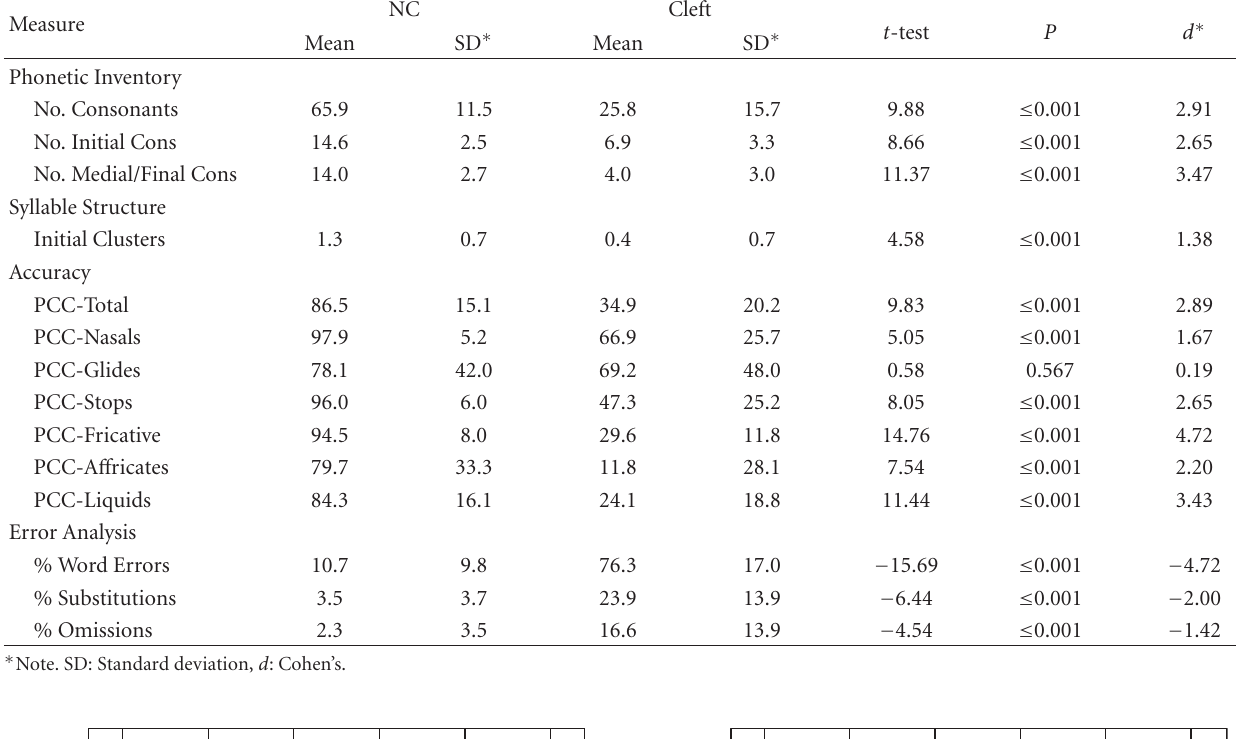
Table 2: Mean and standard deviation for PEEPS measures for children with and without cleft palate and statistical comparisons.